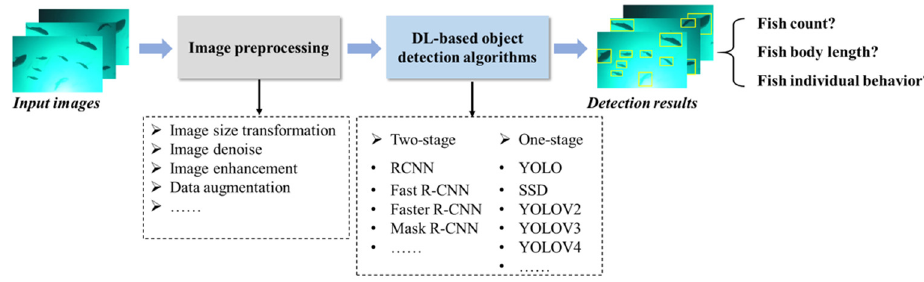
Figure 1. Flow chart of the application of DL-based object detection techniques in aquaculture.